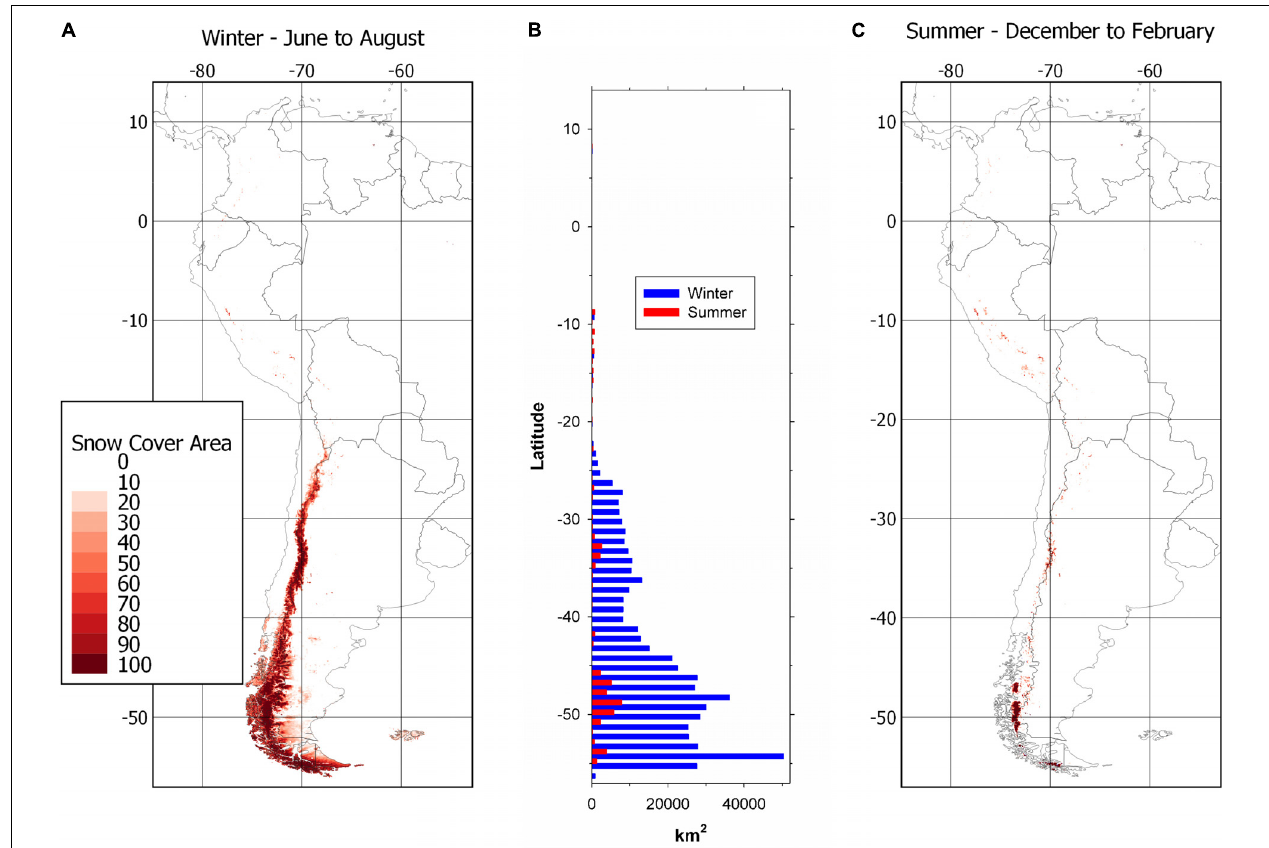
FIGURE 1 | (A,C) Percentage of snow covered area in the Andes, averaged for the winter (June to August) and summer (December to February) seasons, respectively, and derived from MODIS sensors over the period 2000–2019. (B) Surface area covered with snow (NDSI > 0.4) during the two seasons mentioned above. Note the substantial differences in snow covered area at different times of the year. Source: NASA NSDIC DAAC